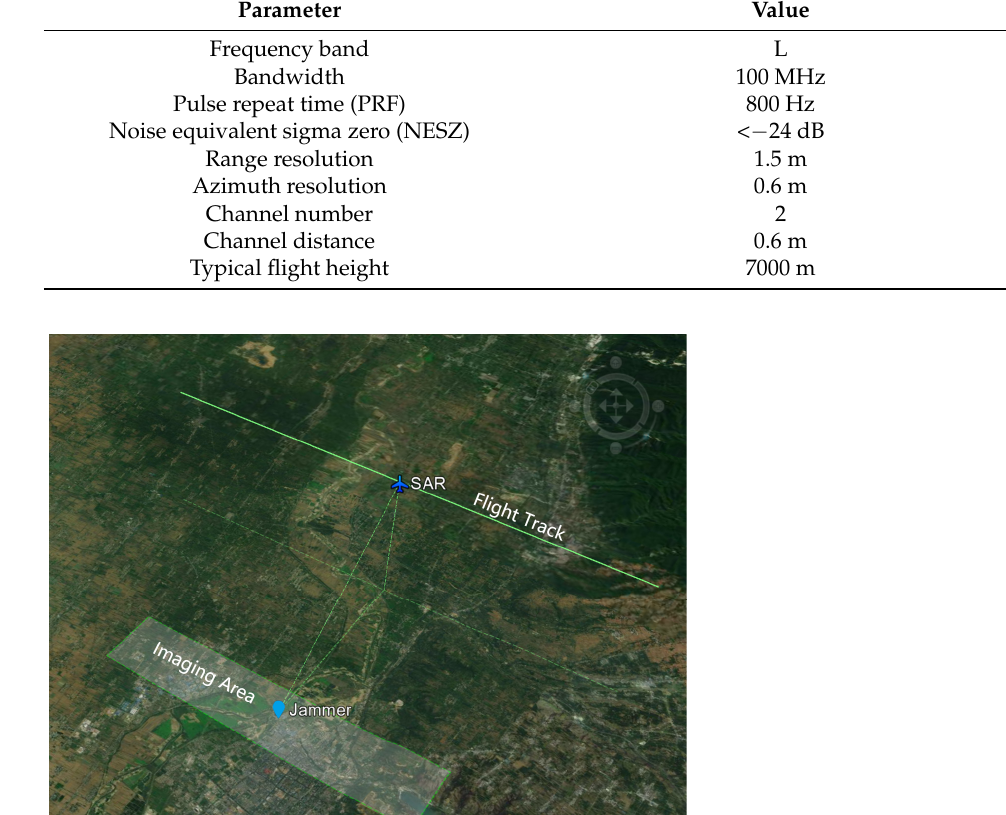
Figure 12. Optical image of the imaging area and the location and orientation of the jammer.